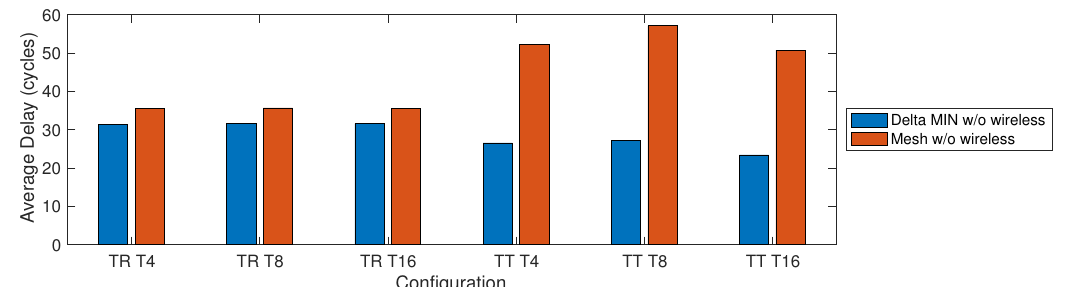
Figure 21. Average delay (cycles) in non-saturated conditions for Delta MIN and mesh topologies of size 256.